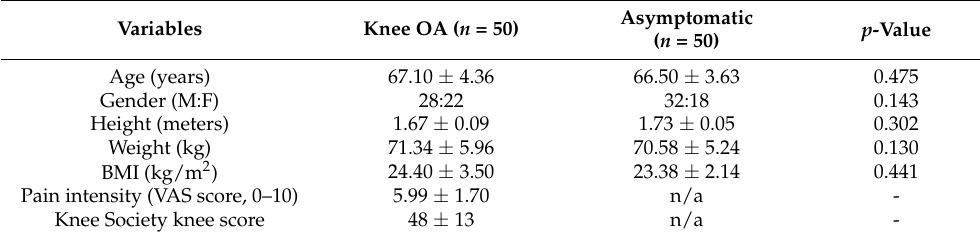
Table 1. Physical and demographic characteristics of study participants.